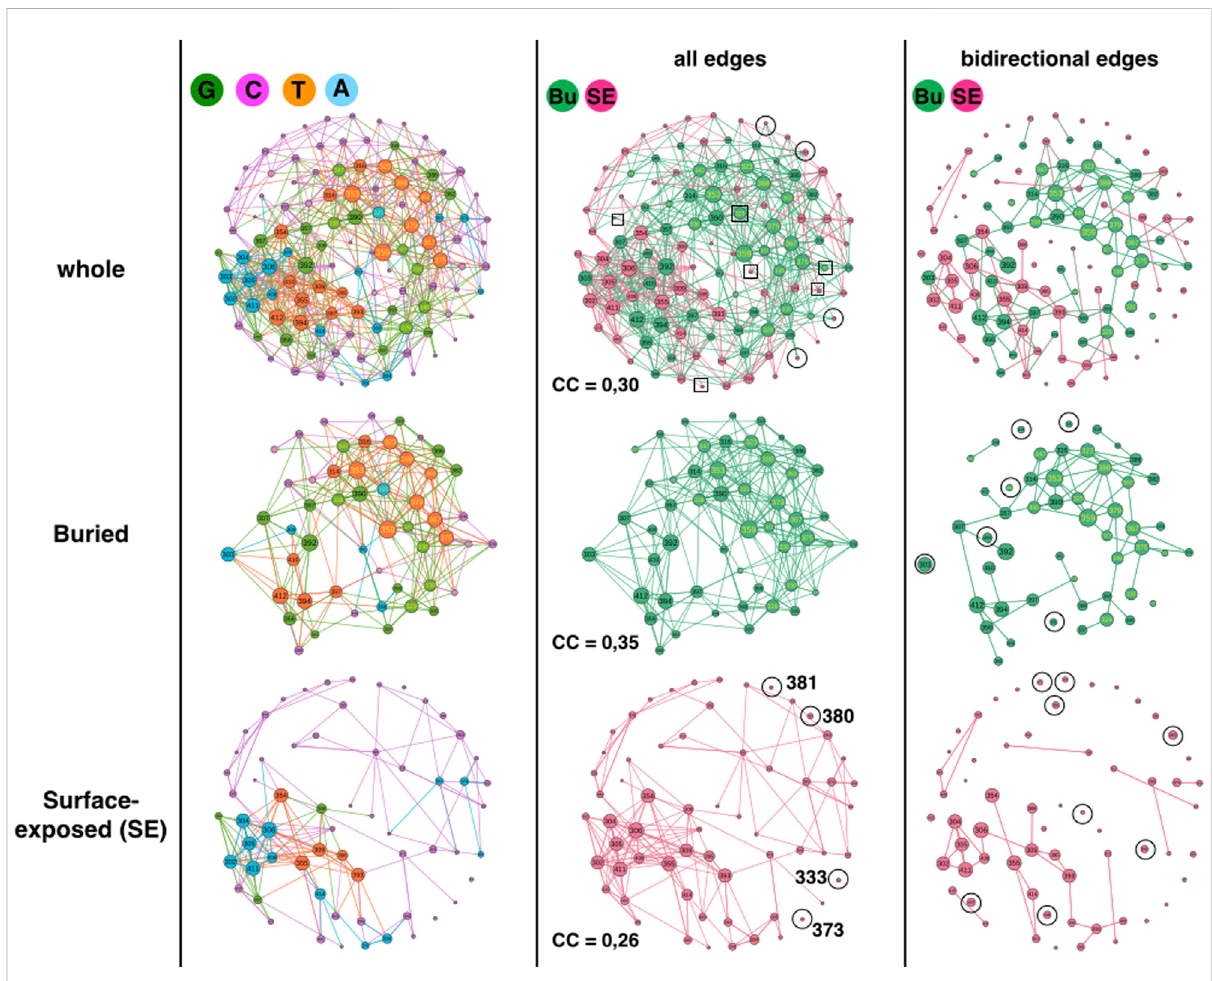
FIGURE 2 1BE9 GCAT network features of buried (Bu) and surface exposed (SE) sub-networks. The whole GCAT network, the buried and SE GCAT sub- networksareshownontheupper,middleandlowerpanels,respectively.Theleft,middleandrightcolumnsaretheGCATclassi fi cation,allin fl uences and bidirectional mutual in fl uences, respectively. The square boxes indicate nodes that are involved in homogeneous in fl uences only (i.e., edges SE to SE or edges Bu to Bu), the circles indicate nodes that are involved in heterogeneous in fl uences only (i.e., edges SE to Bu or edges Bu to